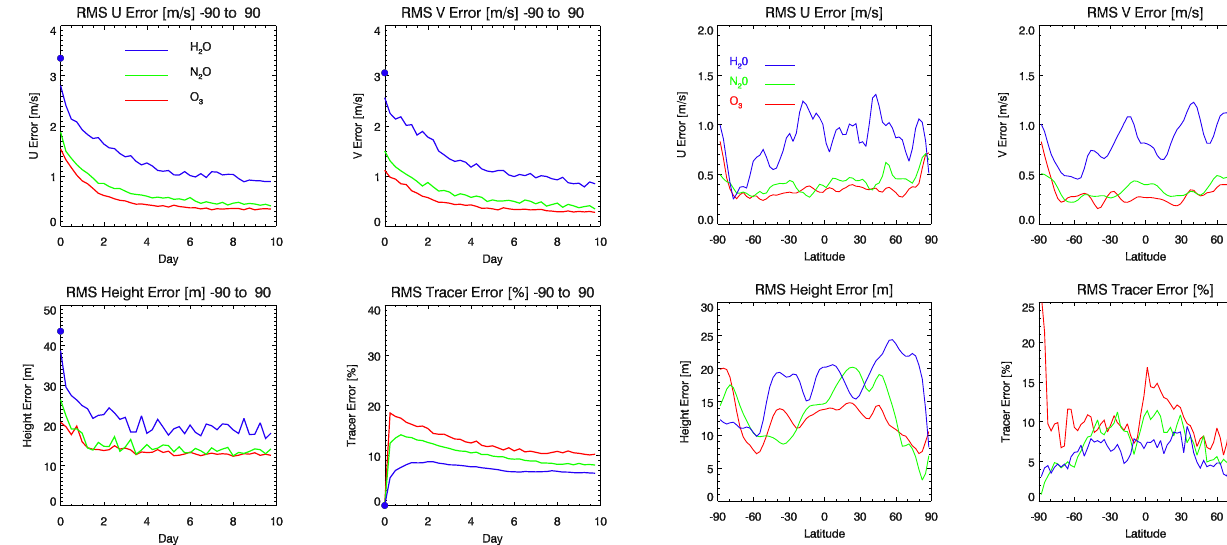
Fig. 8. RMSE for zonal wind, meridional wind, height, and tracer as a function of latitude for the MLS experiment: O 3 (red), N 2 O (green), and H 2 O (blue). Results after 10 days of cycling are shown. Units are ms − 1 for zonal and meridional wind, m for height, and tracer % relative to σ ob .